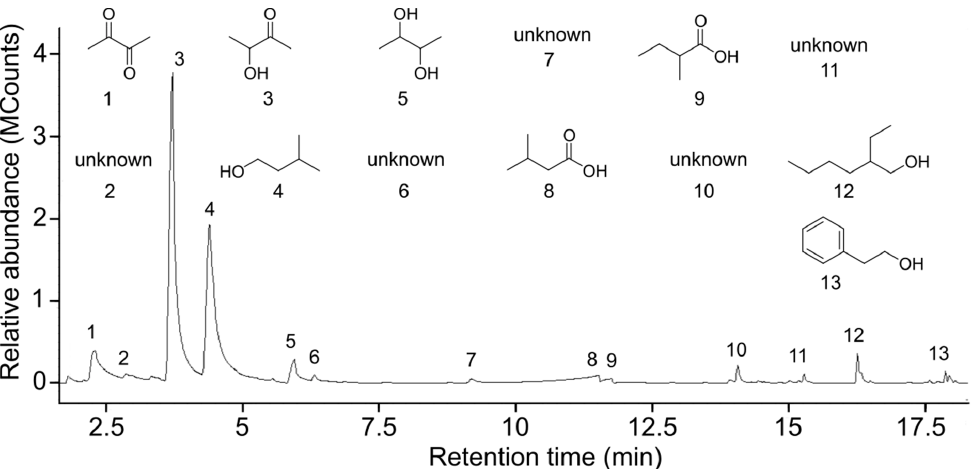
Figure 2. Total ion chromatogram of pea aphid honeydew odorants collected on, and thermally desorbed from, a solid-phase micro extraction (SPME) fibre. Compound identity is as follows: 1 = butanedione; 2 = unknown; 3 = 3-hydroxybutanone; 4 = 3-methylbutan-1-ol; 5 = 2,3-butanediol; 6 = unknown; 7 = unknown; 8 = 3-methylbutanoic acid; 9 = 2-methylbutanoic acid; 10 = unknown; 11 = unknown; 12 = 2-ethylhexanol; 13 = 2-phenylethanol. Table 1. Details of treatment and control stimuli, amount of stimuli tested, type of bioassay design, and number of replicates (N) tested with yellow fever mosquitoes in Experiments 1–15. Exp.